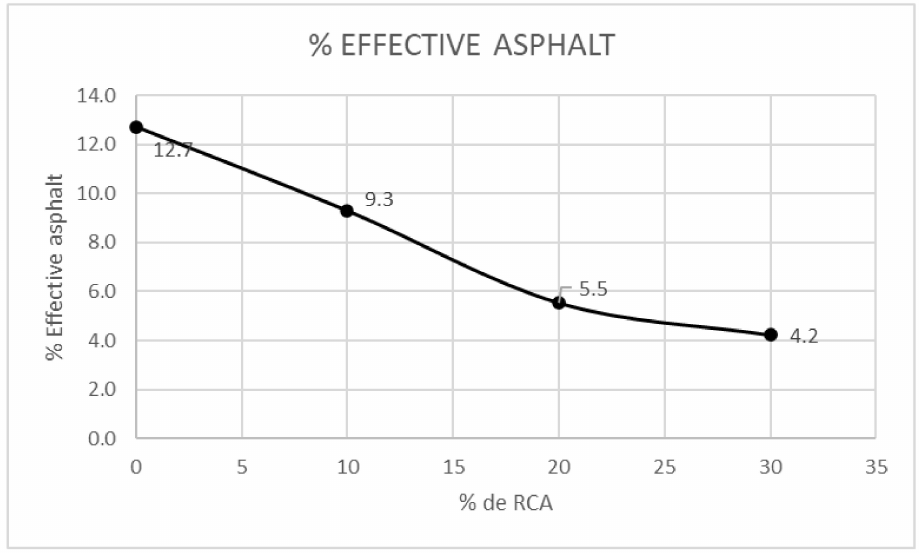
Figure 14. Effective asphalt by RCA content